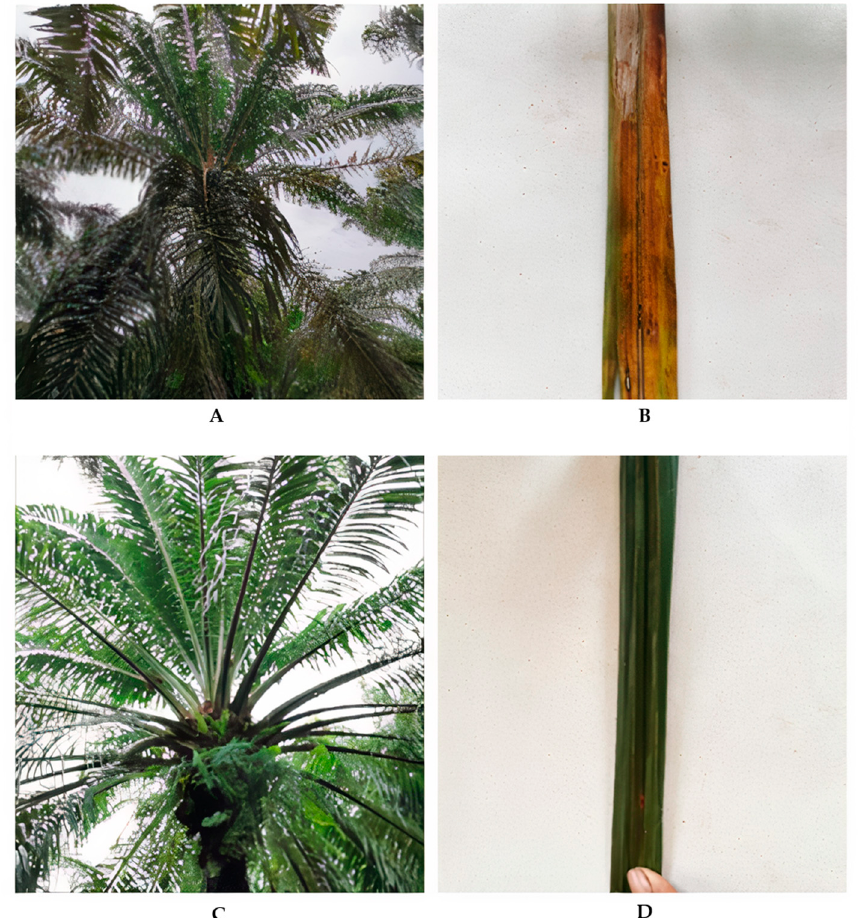
Figure 2. Canopy and leaf samples of a diseased oil palm tree (generalized symptoms independent of the disease) (upper insets) ( A , B ) and healthy oil palm tree (i.e., no foliar symptoms) (lower insets) ( C , D ). Photo credit: Rachane Malinee.